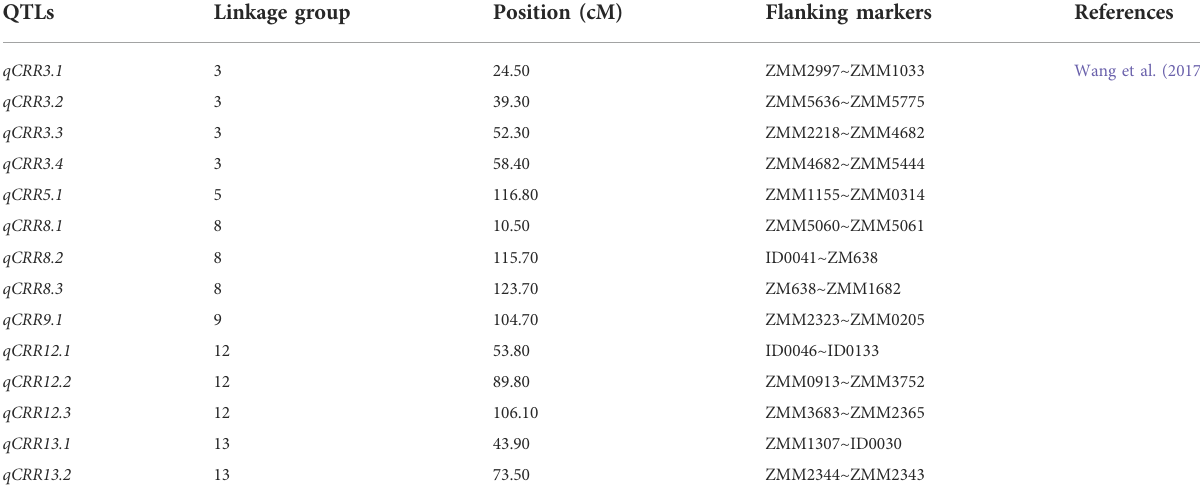
(Figure 6). Sesame has different genotypes with different seed coat colors, with white-colored and thin seed coat varieties the most favored (Wei et al., 2016; Tripathy et al., 2019). Wei et al. (2016) reported that the cultivated variety “ Zhonghzi13 ” has white seed coat color whereas the landrace “ Mishuozhima ” has black seed coat color.